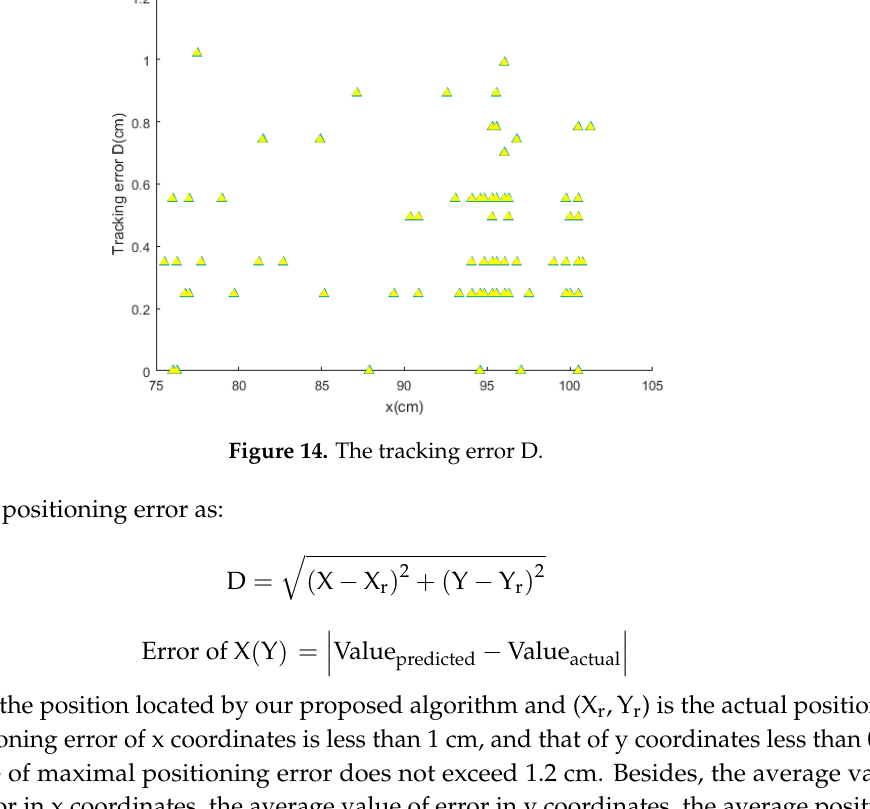
Figure 13. The error of position value of y coordinates.